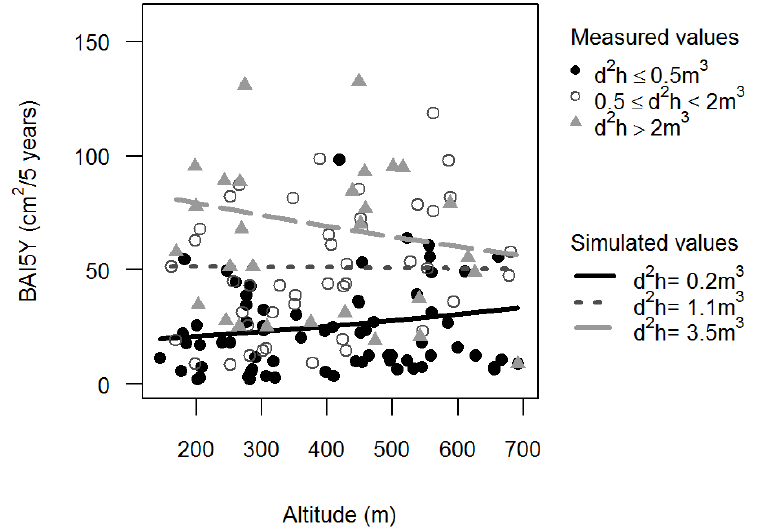
Figure 3. Effect of altitude and tree size on basal area increment over a 5-year period ( BAI 5 Y ). Simulated values for BAI 5 Y for each size class were obtained by fixing d 2 h to its mean value within each